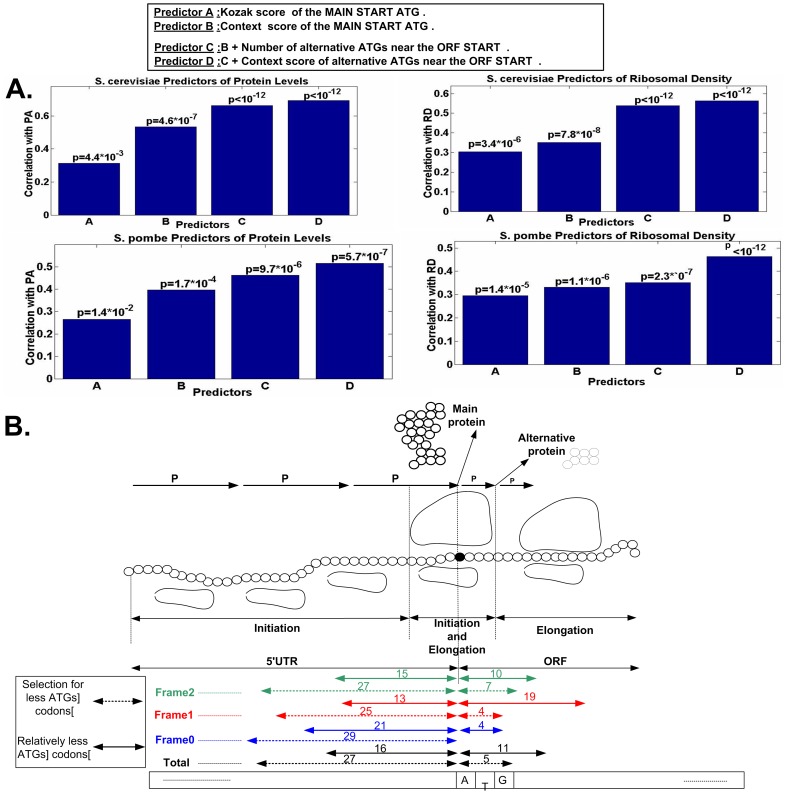
A. The predictive power of the new set of translation initiation rules.The correlation between four predictors based on increasing number of initiation rules described in this study with ribosomal density and protein levels in S. pombe and S. cerevisiae. B. A possible generalized model of translation initiation. P denotes the probability to continue the scanning stage of the pre-initiation complex; larger P denotes larger probability. The figure includes for each of the three frames, the mean (over all the analyzed organisms) genomic region at the end of the 5′UTR and the beginning of the ORF that is under selection for less ATGs, and the region that statistically includes less codons than the rest of the 5′UTR/ORF respectively (rounded to the closest integer).